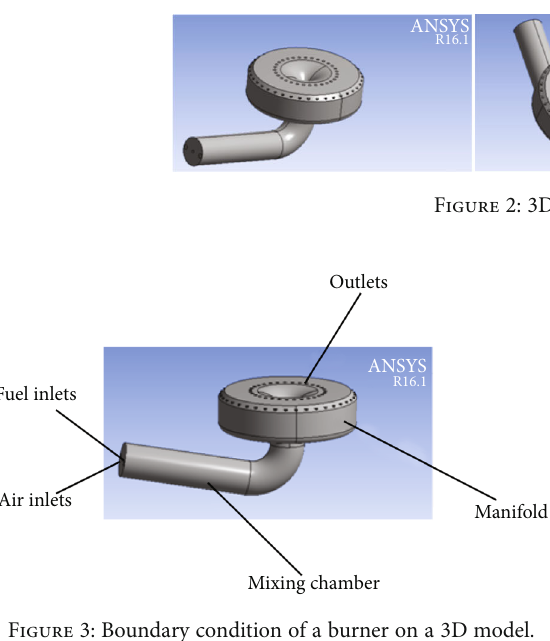
Figure 3: Boundary condition of a burner on a 3D model.